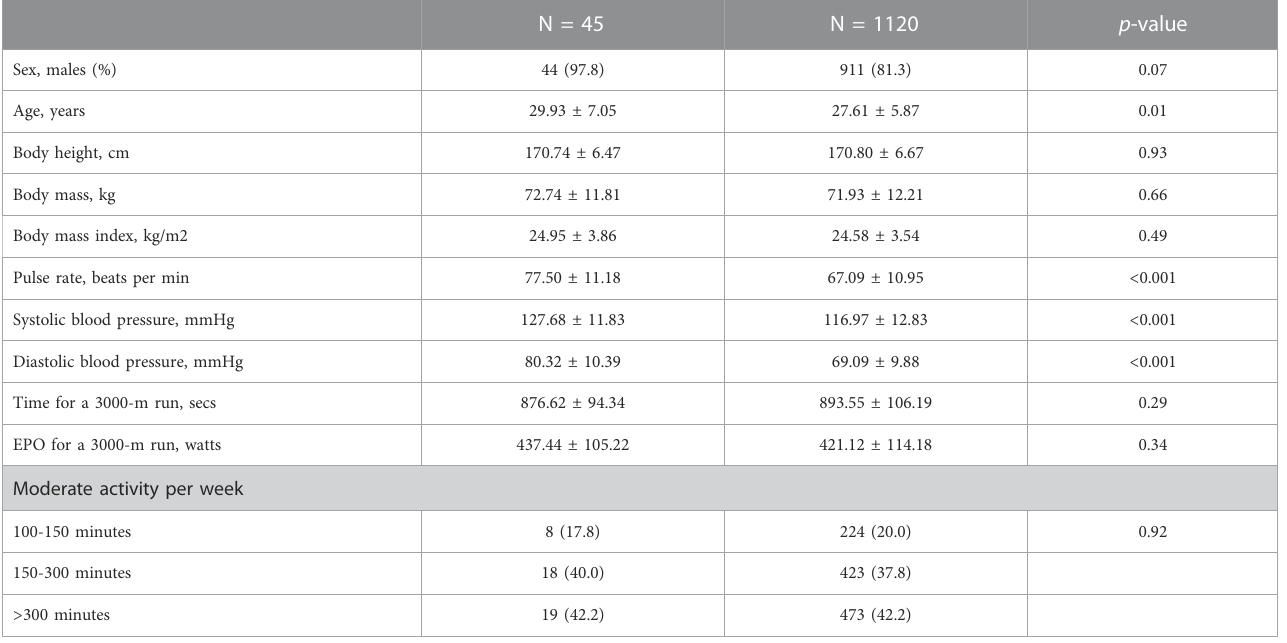
TABLE 1 Clinical Characteristics of the Overall Participants for a Run Field Test and the Selected Participants for a Cardiopulmonary Exercise Testing. N = 45 N = 1120 p -value